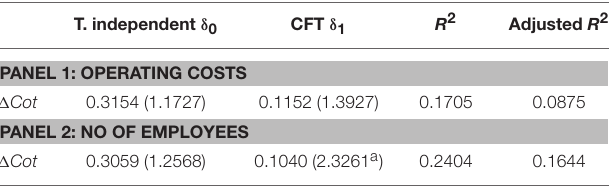
TABLE 5 | Estimation of the relationship between sectoral FT coefficients and variations in stock prices. T. independent δ